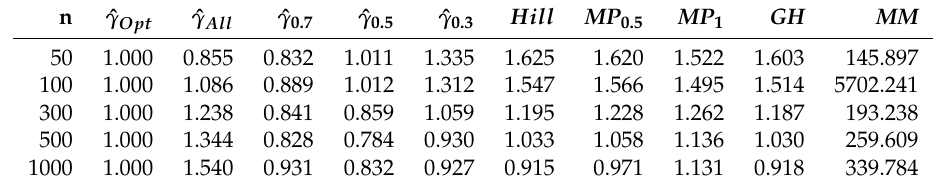
Table 4. Relative RMSE of the estimators for the Fréchet(1.5) distribution; 1000 Montecarlo replications.